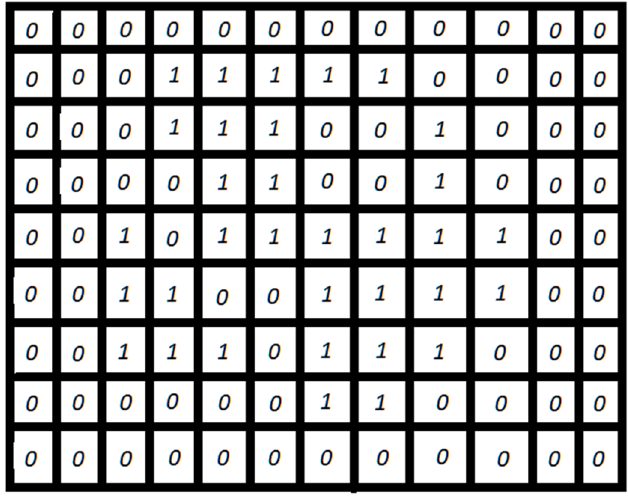
Figure 1. An abstract representation of information that is received by a sensory organ, such as the light rays absorbed by neuronal cells across the retinal surface of the camera eye [3].